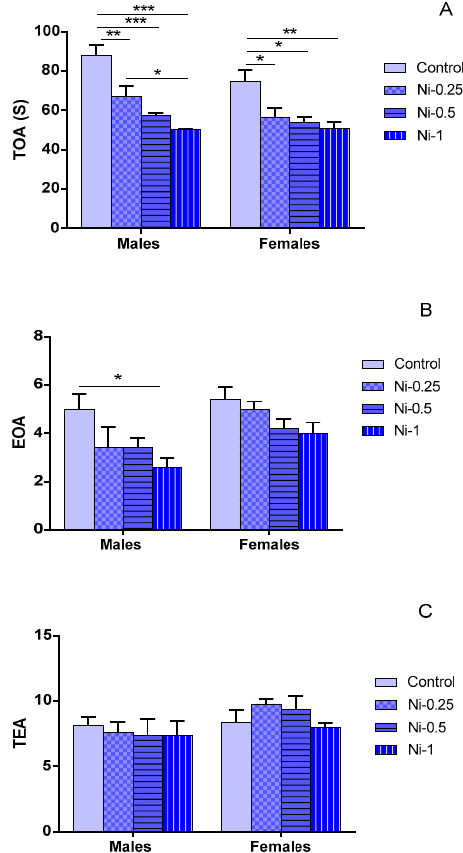
Figure 2. ( A ) Number of entries in exposed arms (EOA); ( B ) Total amount of time spent in exposed arms (TOA); and ( C ) Total number of arms entries (TEA) in elevated plus maze in female and male rats after 2 month of treatment with 0.9% of NaCl (Control), 0.25 mg/kg (Ni-0.25), 0.5 mg/kg (Ni-0.5), and 1 mg/Kg (Ni-1) of Ni. Results are expressed as mean ± SEM. The significance level is 0.05. * p < 0.05, ** p < 0.01, *** p < 0.001.